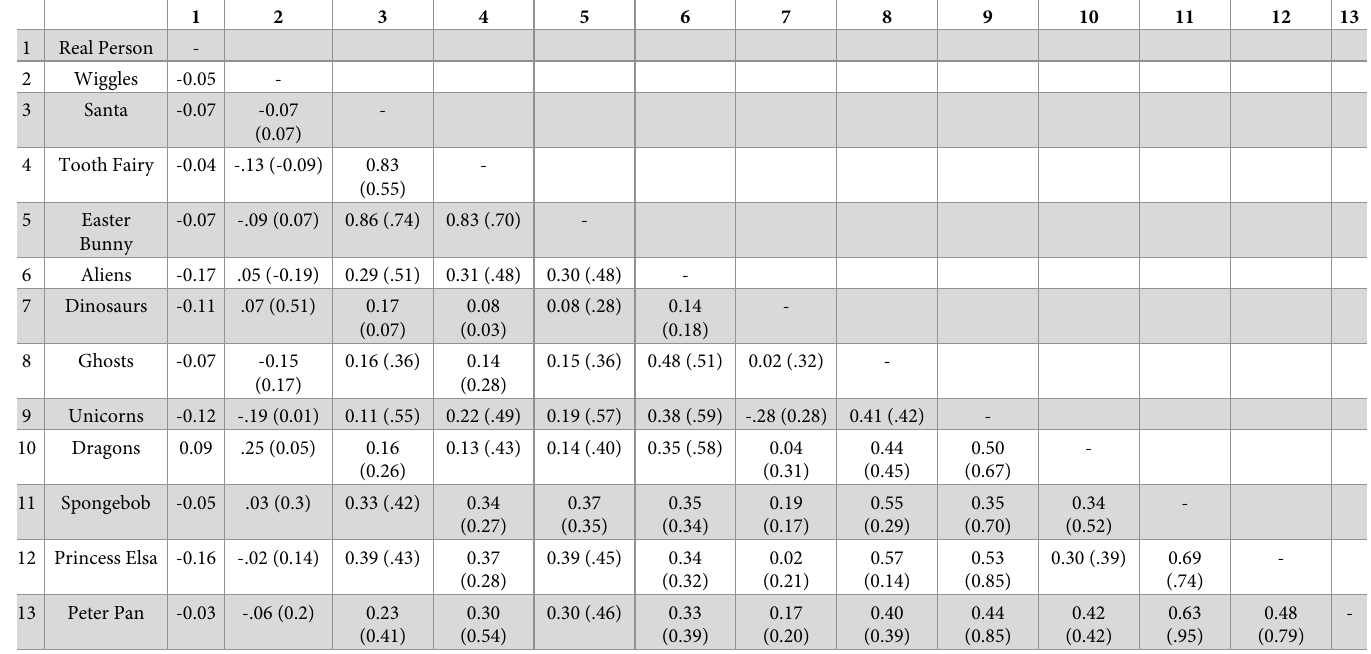
Table 6. Table of correlation between figures (with correlations from main manuscript in